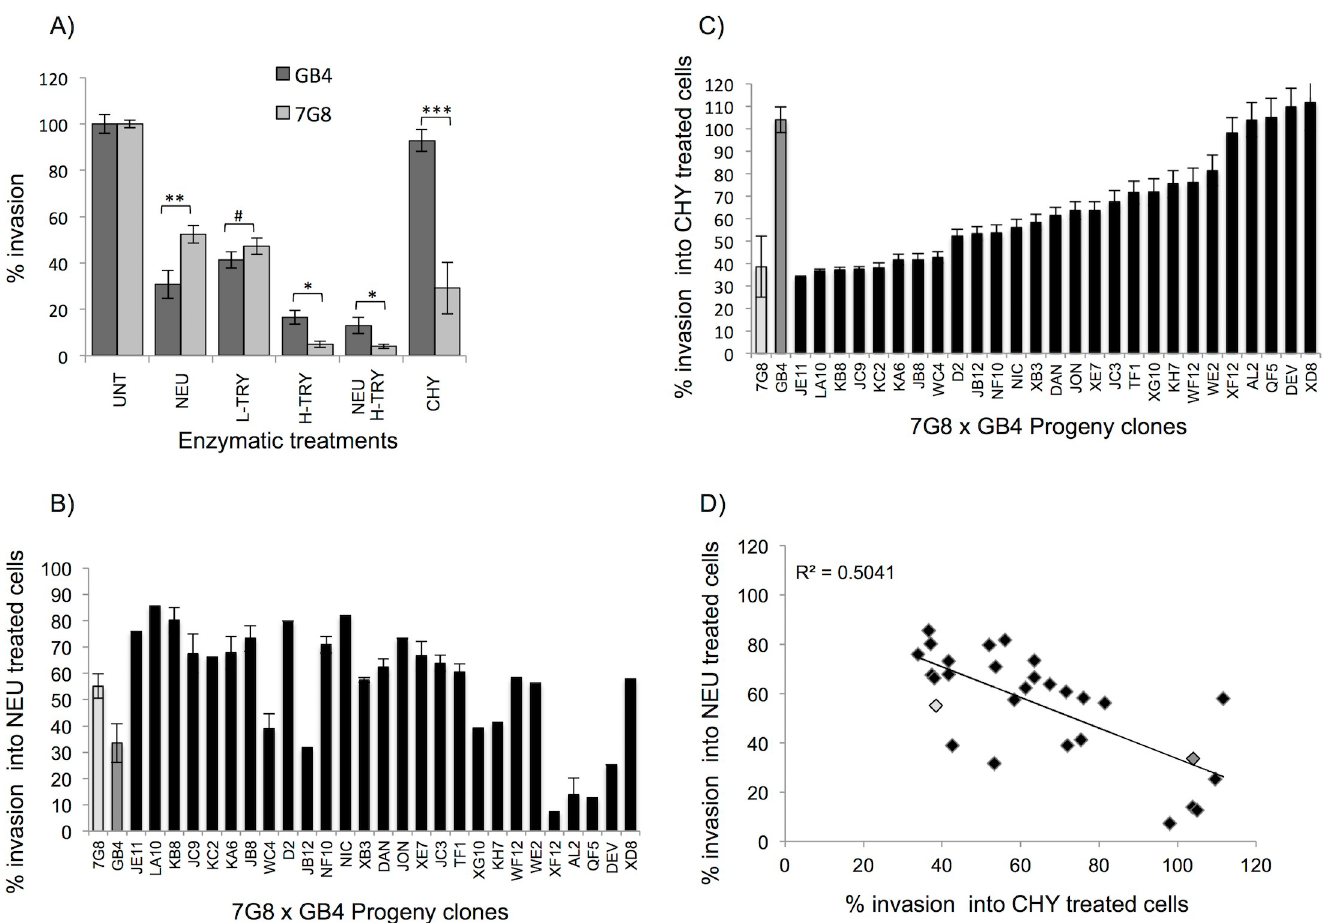
Fig 1. Erythrocyte invasion efficiency of progeny clones of the 7G8 x GB4 cross. (A) Invasion rates of the 7G8 (light grey bars) and GB4 (dark grey bars) parental strains into enzyme treated or untreated cells. # p-value = 0.25, � p-value ffi 0.012, �� p-value = 0.003, ��� p-value = 0.00013. (B, C) Invasion profiles of 27 progeny clones (black bars) and parental strains (light grey: 7G8, dark grey: GB4) into NEU (B) and CHY treated (C) cells. Percentage values are relative to invasion into untreated cells. Results represent mean values from a minimum of 3 biological and 3 technical replicates. Error bars are standard error of the mean. (D) Correlation of mean invasion rates of progeny (black diamond) and parental (7G8: light gray, GB4: dark gray) into NEU and CHY treated erythrocytes.